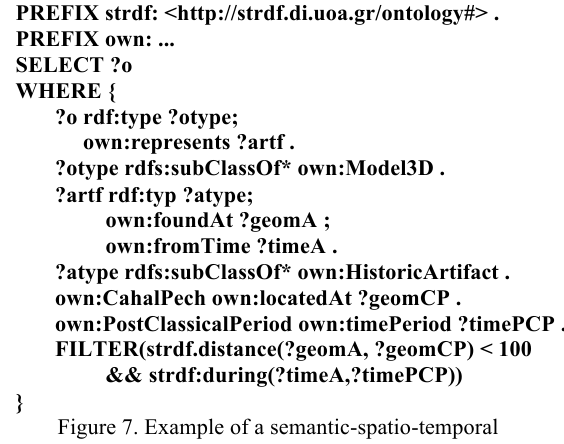
Figure 7. Example of a semantic-spatio-temporal stSPAQRL